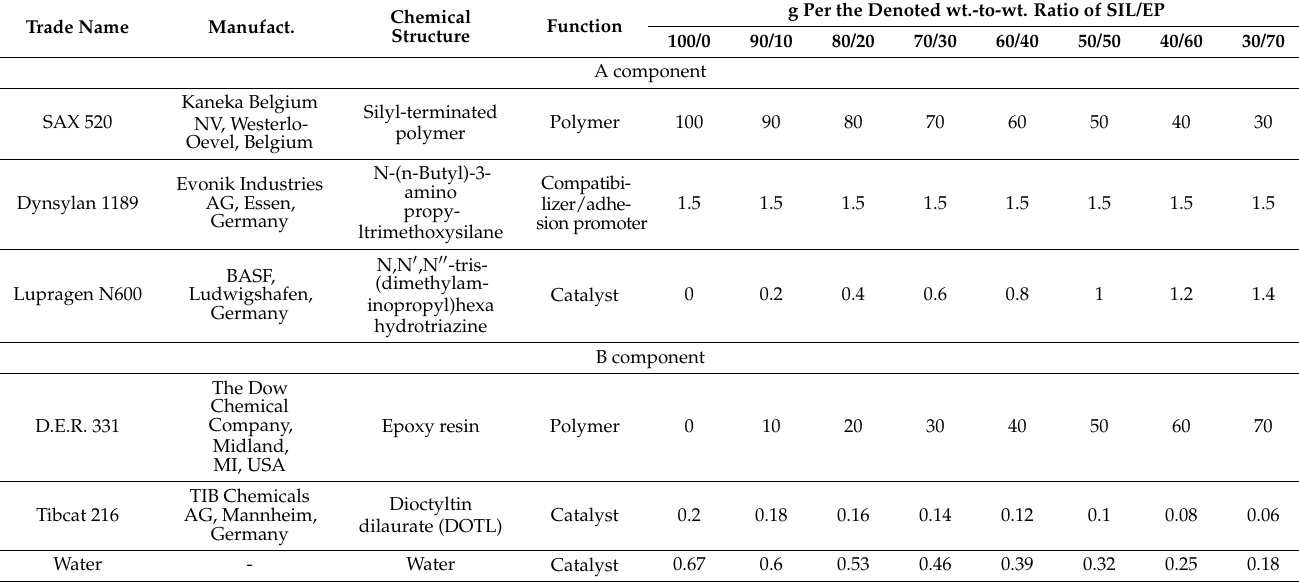
Table 2. Characterization of two-component SIL/EP formulations (model system with